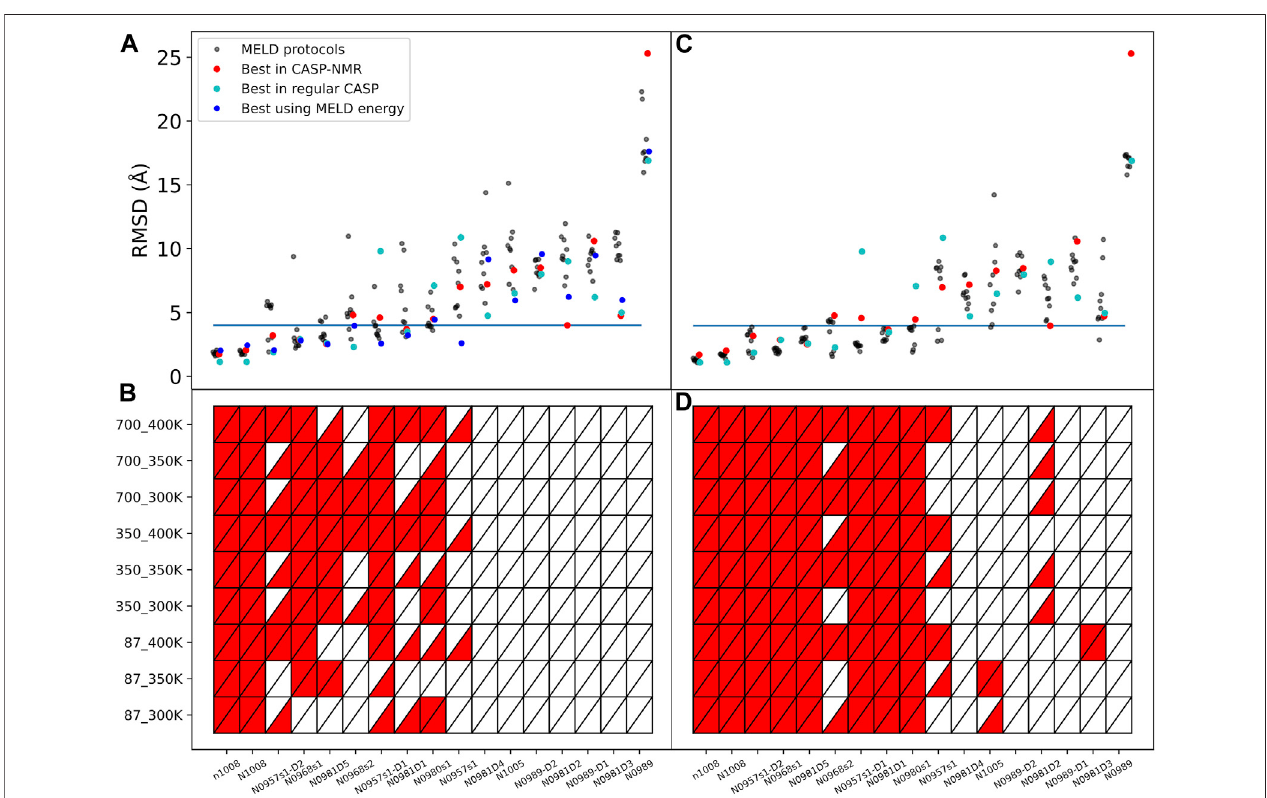
FIGURE 2 | Quality of structure predictions. (A,B) uses the 4-residue ambiguous dataset and (C,D) use the correct assignment of the NMR data ( 4-residue true dataset ). We compare nine different HT-REMD protocols (black dots). The blue dots represent the lowest restraint energy structure of the best performing protocol ( k (cid:2) 350 kJmol − 1 nm − 2 and T (cid:2) 400 K). The lower panels quantify each MELD protocol ’ s ability to identify the native structures as either red (success) or white (failure) in the top 1 (upper triangle) or top 5 (lower triangle) cluster centroids. The y-axis notation is k_T, where k refers to the force constant used ( kJmol − 1 nm − 2 ) and T to the temperature in